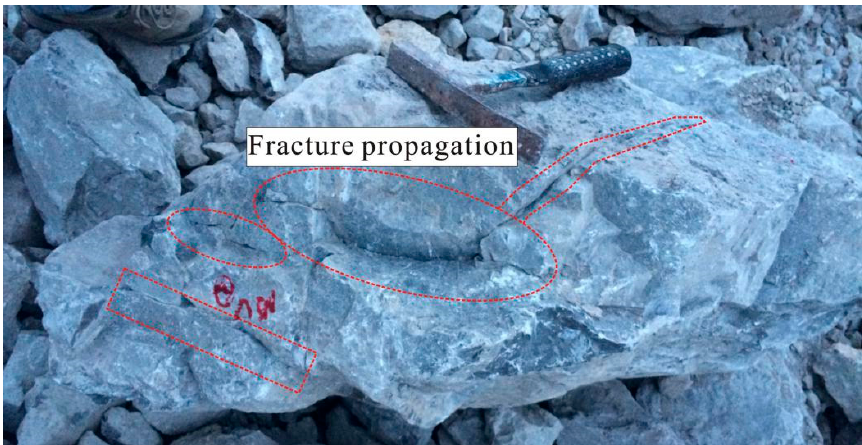
Figure 12. The fracture propagation on a block formed by excavation disturbance from the Qiyueshan Tunnel of the Lichuan–Wanzhou Railway.